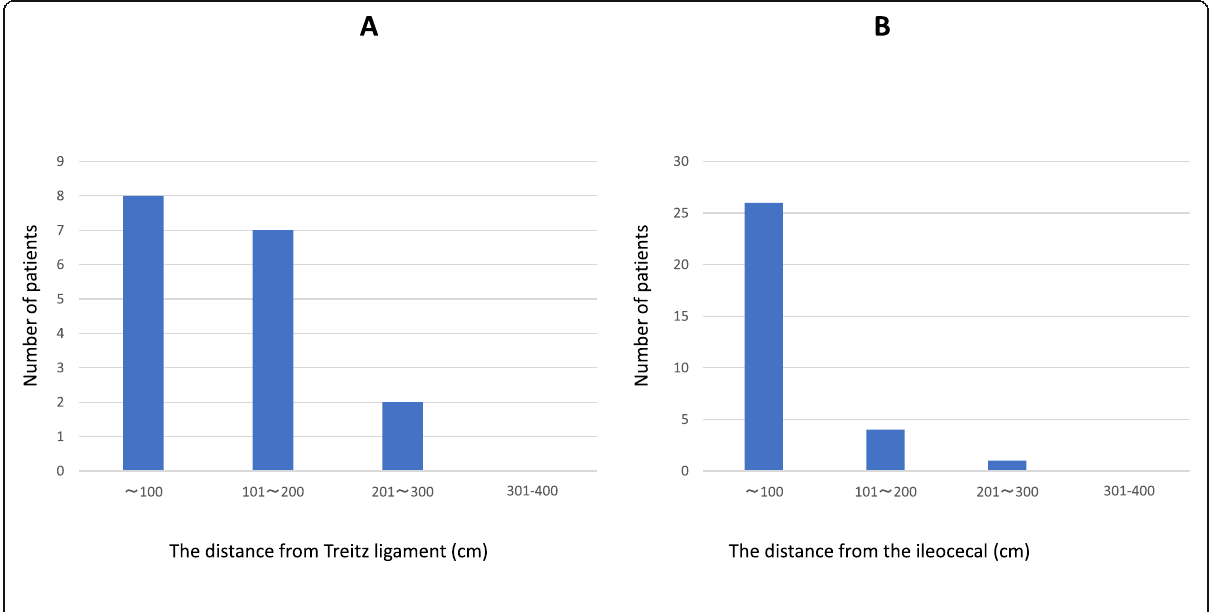
Fig. 6 Site of the small bowel stenosis after blunt trauma ( n = 54). a Distance from Treitz ligament to the small bowel stenosis. b Distance from the ileocecal valve to the small bowel stenosis